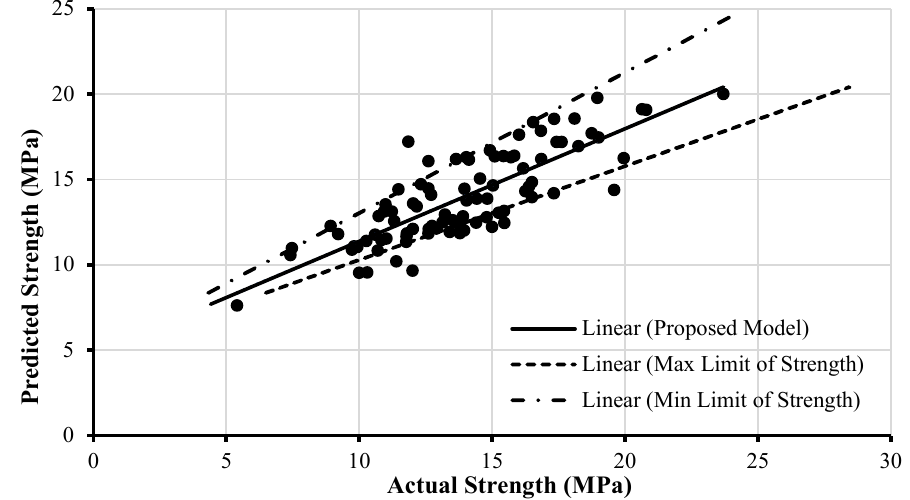
Figure 16. Actual vs. predicted strength in the case of all bricks combined.